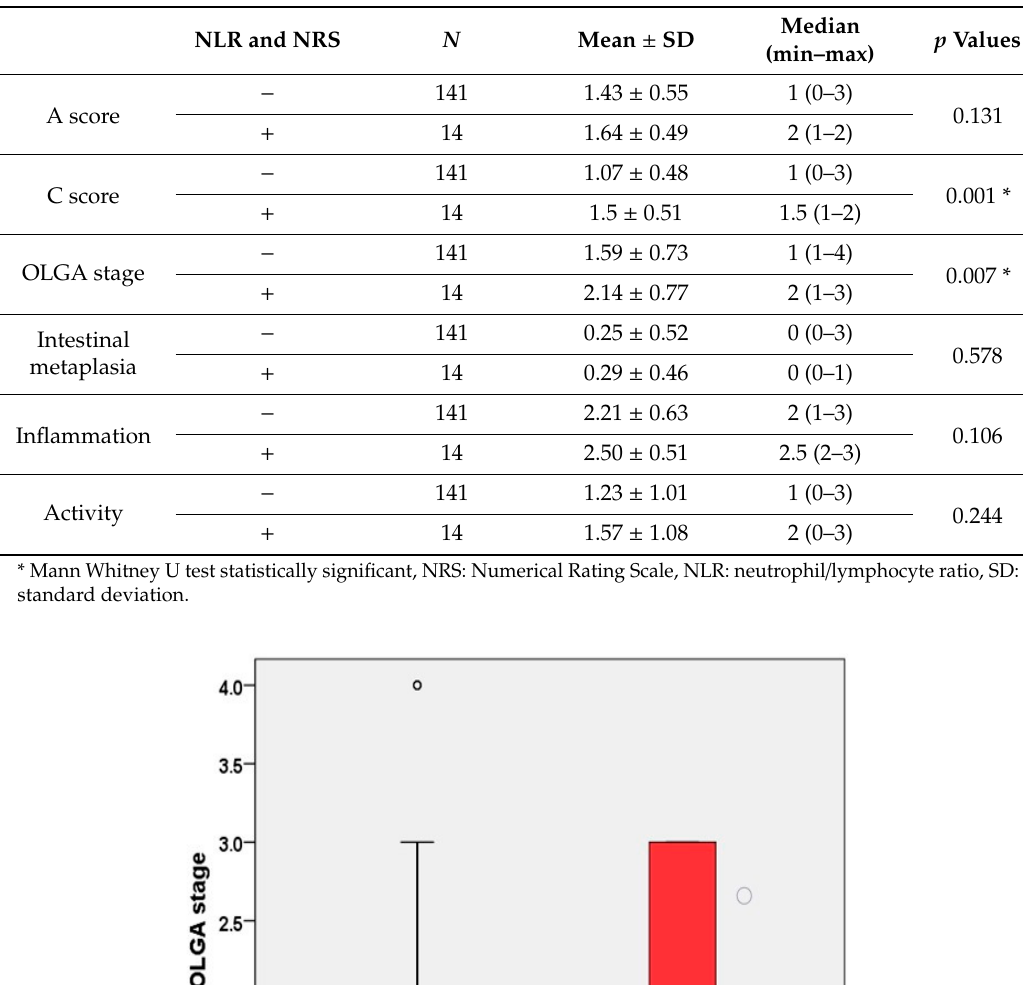
Figure 3. Comparison of the OLGA stage according to the neutrophil to lymphocyte ratio (NLR) and the NRS groups ( n = 14, n = 141). Table 4. Comparison of gastric parameters according to NLR and NRS groups ( n = 155).